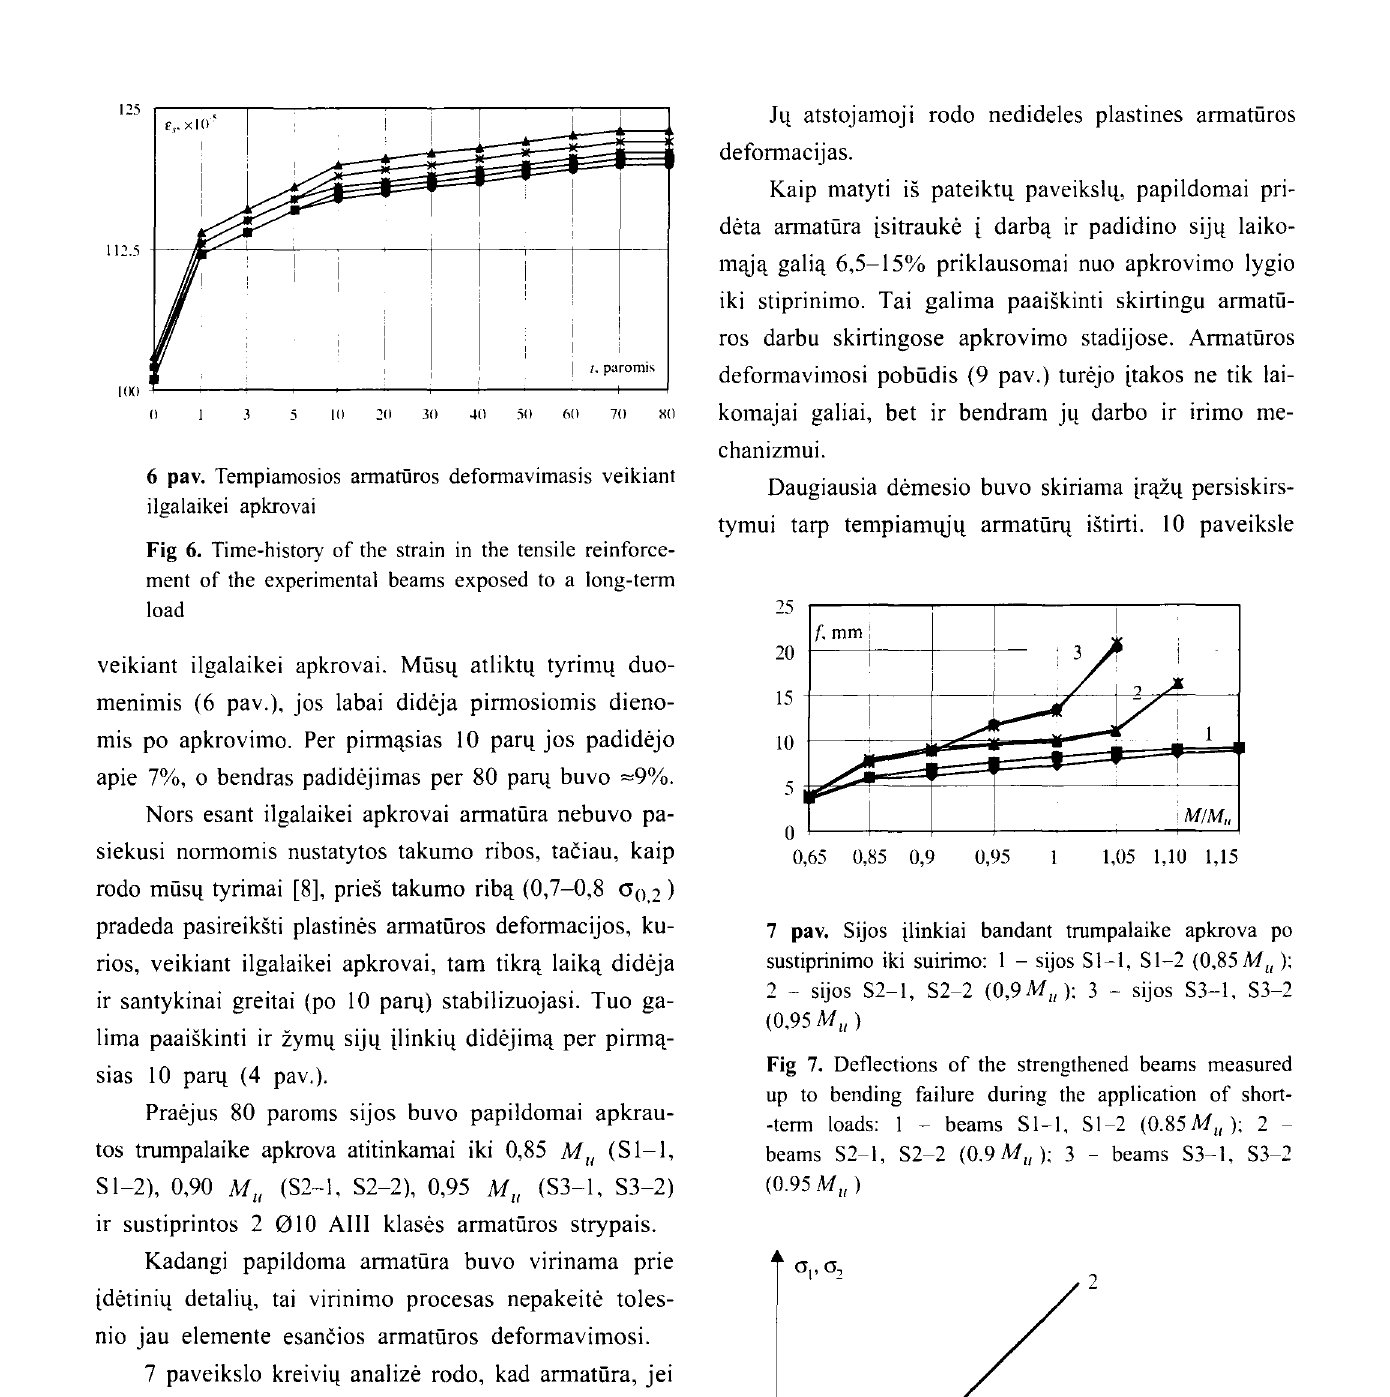
Fig 8. The stress-strain relationships for the reinforce ment cast in concrete (I), for the exterior reinforcement (2) and the reduced reinforcement as given by Eq (6)